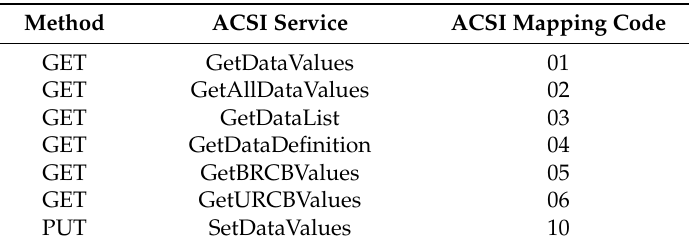
Table 1. FC Services of the IEC61850-to-CoAP Method Mapping.